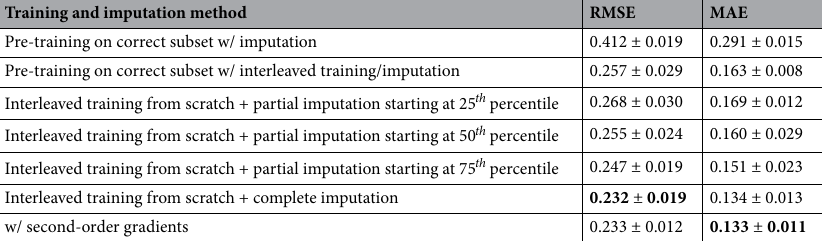
Table 3. Ablation analysis for DINI. Breast dataset was considered with MCAR corruption. Data is reported with 95% confidence intervals. Values corresponding to the lowest error are in [bold].